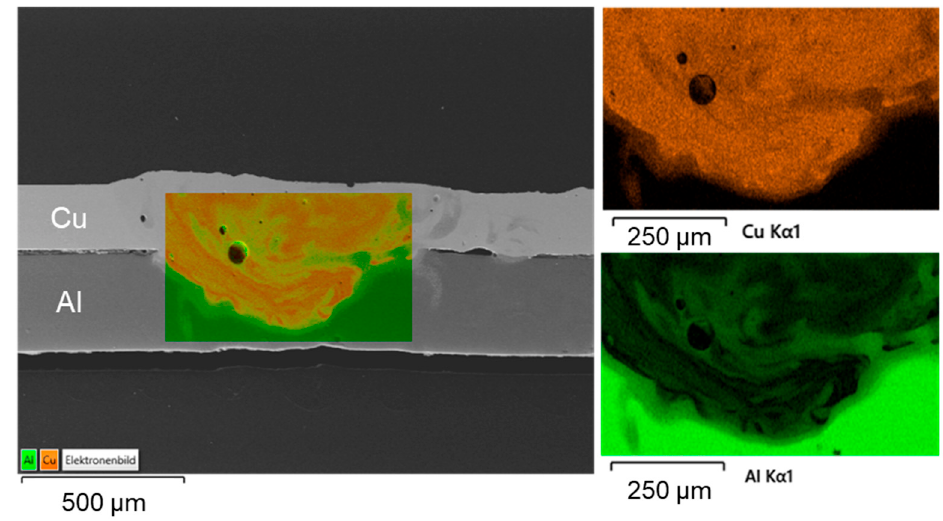
Figure 15. EDS mapping image for the joint cross-section of parameter set #4 (circular beam oscillation, P L = 1500 W, v F = 150 mm/s, f = 150 Hz) showing the elemental distribution of Cu and Al in the weld seam.